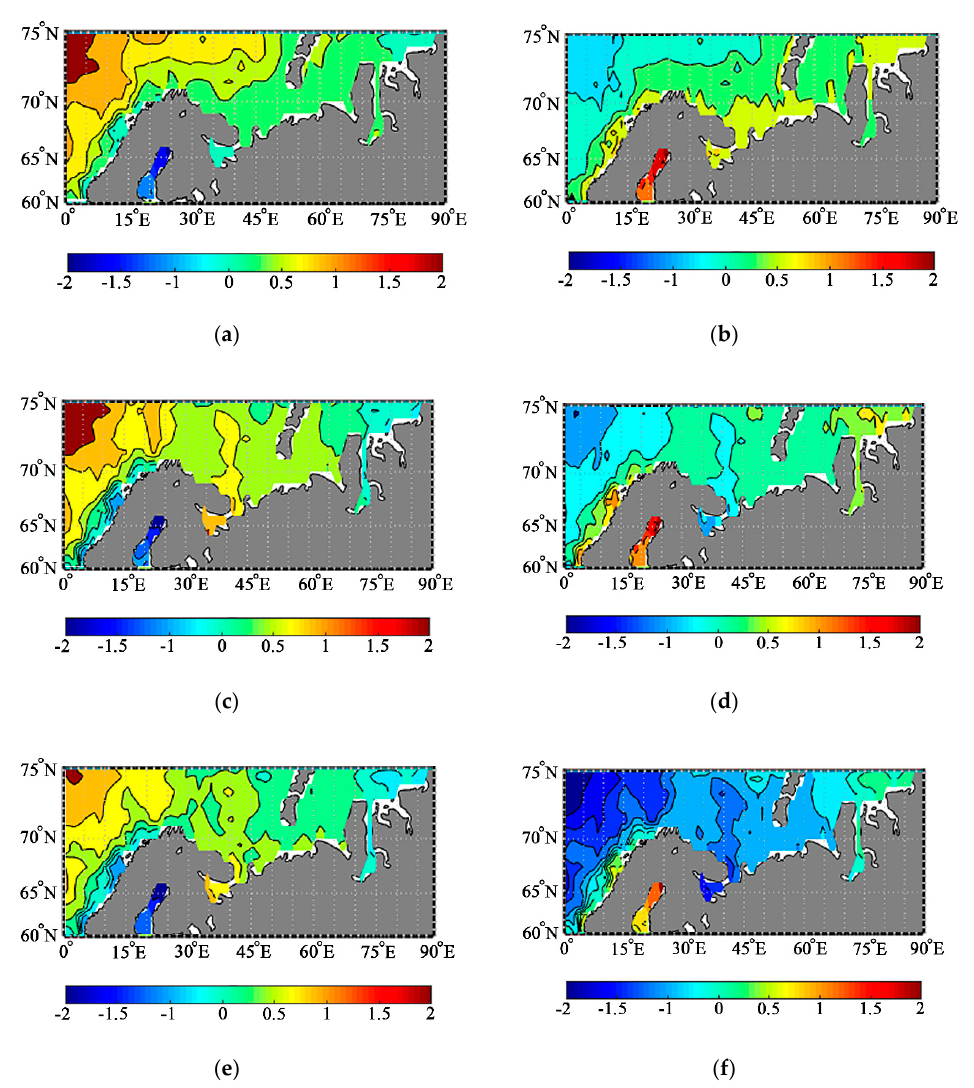
Figure 4. Values of the two first eigenvectors (cid:1857) (cid:3041)(cid:2878)(cid:2869) (cid:2869) (on the left) and (cid:1857) (cid:3041)(cid:2878)(cid:2869) (cid:2870) (on the right) of the matrix (cid:1843) (cid:3041)(cid:2878)(cid:2869) at n = 4, 9, 14 (which corresponds to the 5th, 10th, and 15th days of calculation): ( a ) (cid:1857) (cid:2873)(cid:2869) , ( b ) (cid:1857) (cid:2873)(cid:2870) , ( c ) (cid:1857) (cid:2869)(cid:2868)(cid:2869) , ( d ) (cid:1857) (cid:2869)(cid:2868)(cid:2870) , ( e ) (cid:1857) (cid:2869)(cid:2873)(cid:2869) , ( f ) (cid:1857) (cid:2869)(cid:2873)(cid:2870) .